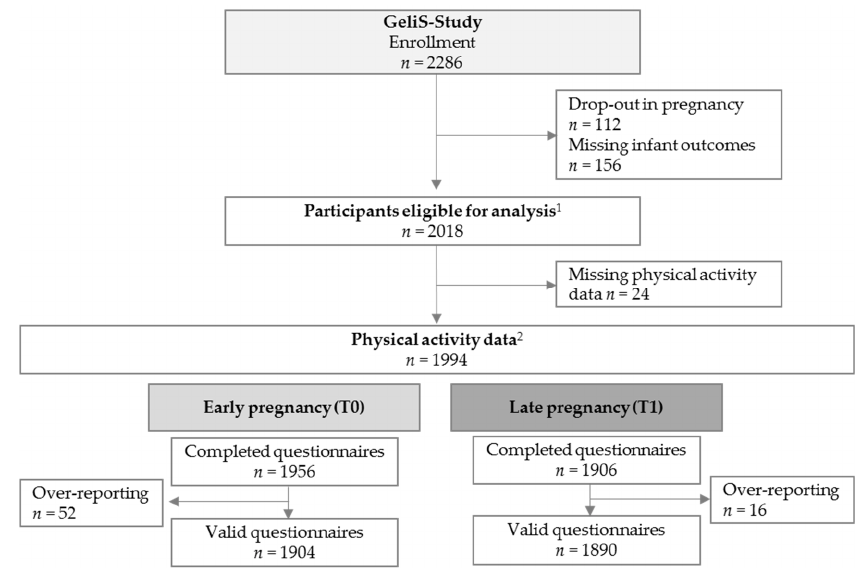
Figure 1. Participant flow and availability of physical activity data. 1 Women without miscarriages, late loss of pregnancy, terminations, pregnancy complications that interfere with the intervention, maternal deaths, and/or that provided at least one of the three infant outcomes (birth weight, birth length, and head circumference). 2 Women who provided PA data at T0 or T1. Abbreviations: PA: